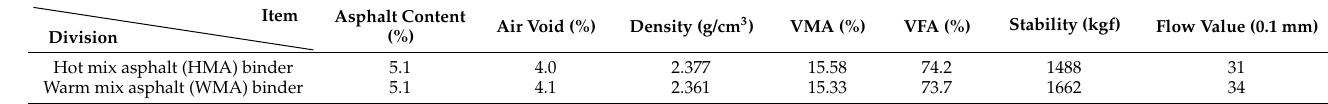
Table 4. Test variables and designation of specimens.